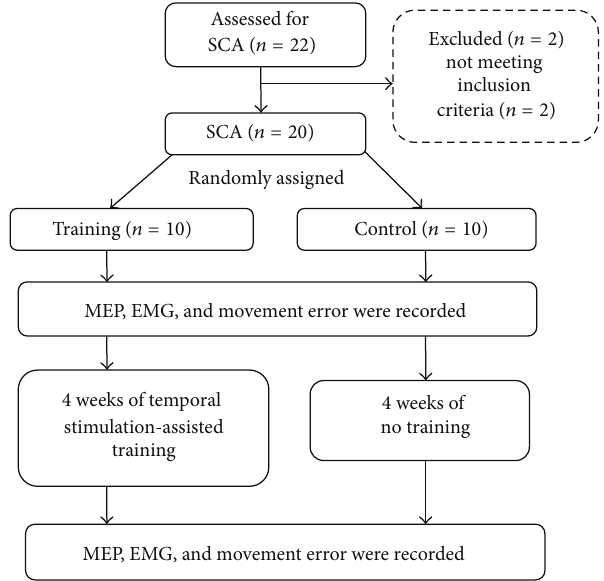
Figure 1: The flowchart of the